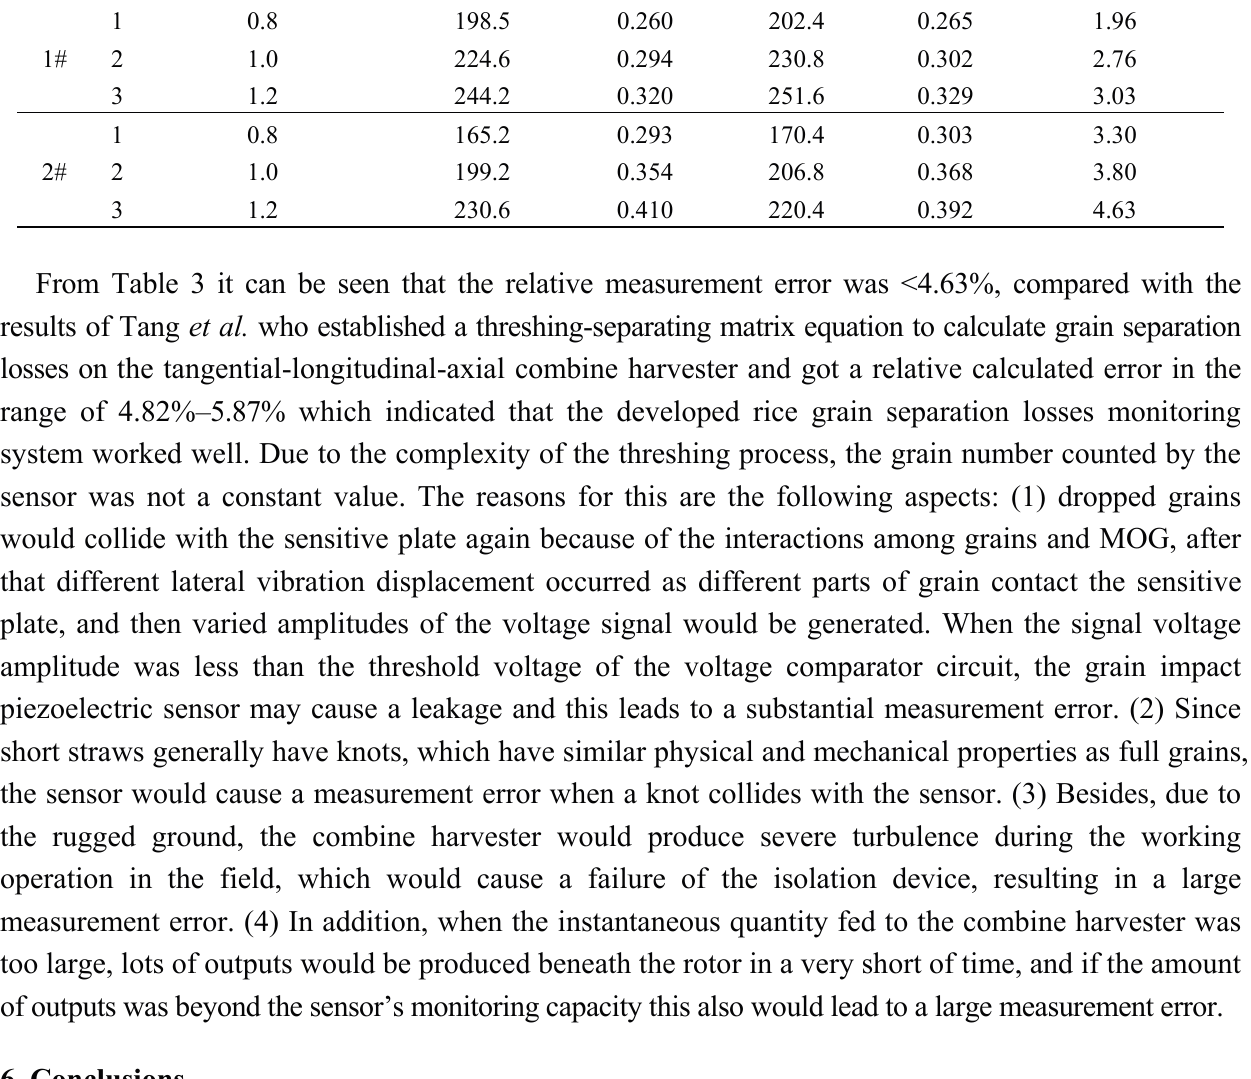
Table 3. Error analysis of separation losses obtained by sensor compared to manual measurement. Separation Losses Tests No. Forward Speed m/s Sensor Manual Relative Error/% Total Amount/g Ratio/% Total Mass/g